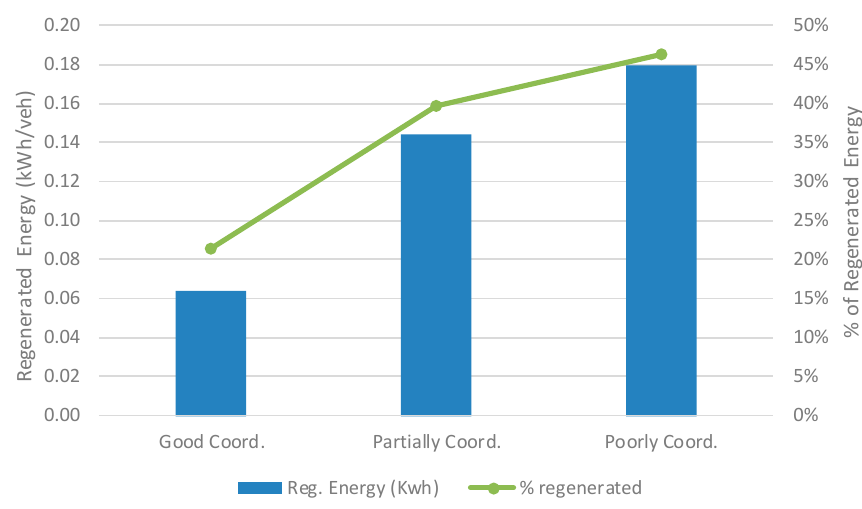
Figure 8. Regenerated energy of BEV for different signal coordination plans.